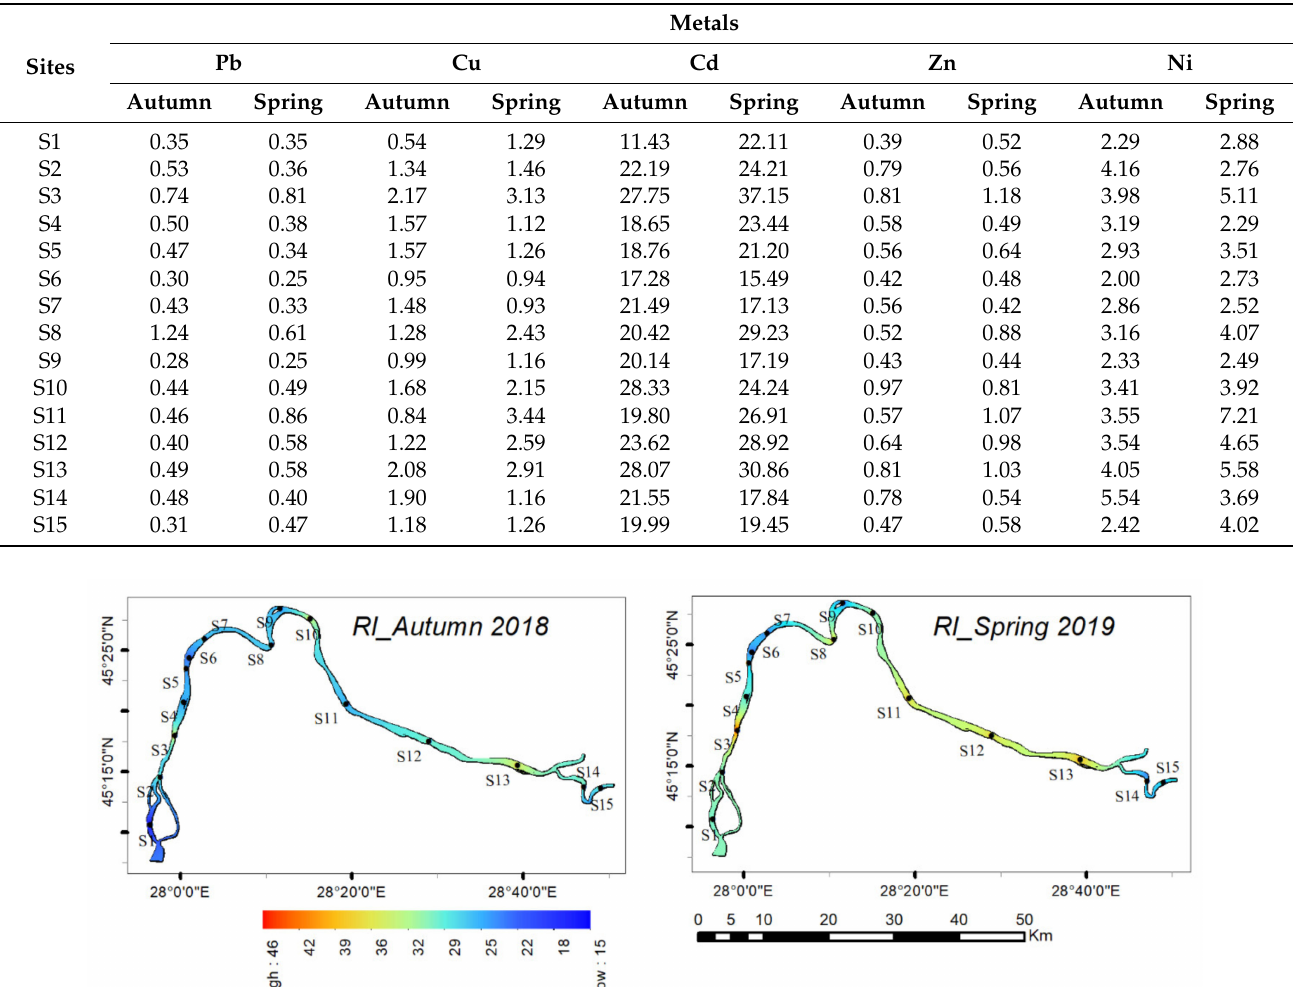
Table 9. Potential ecological risk of individual metal ( Er Me ) values.